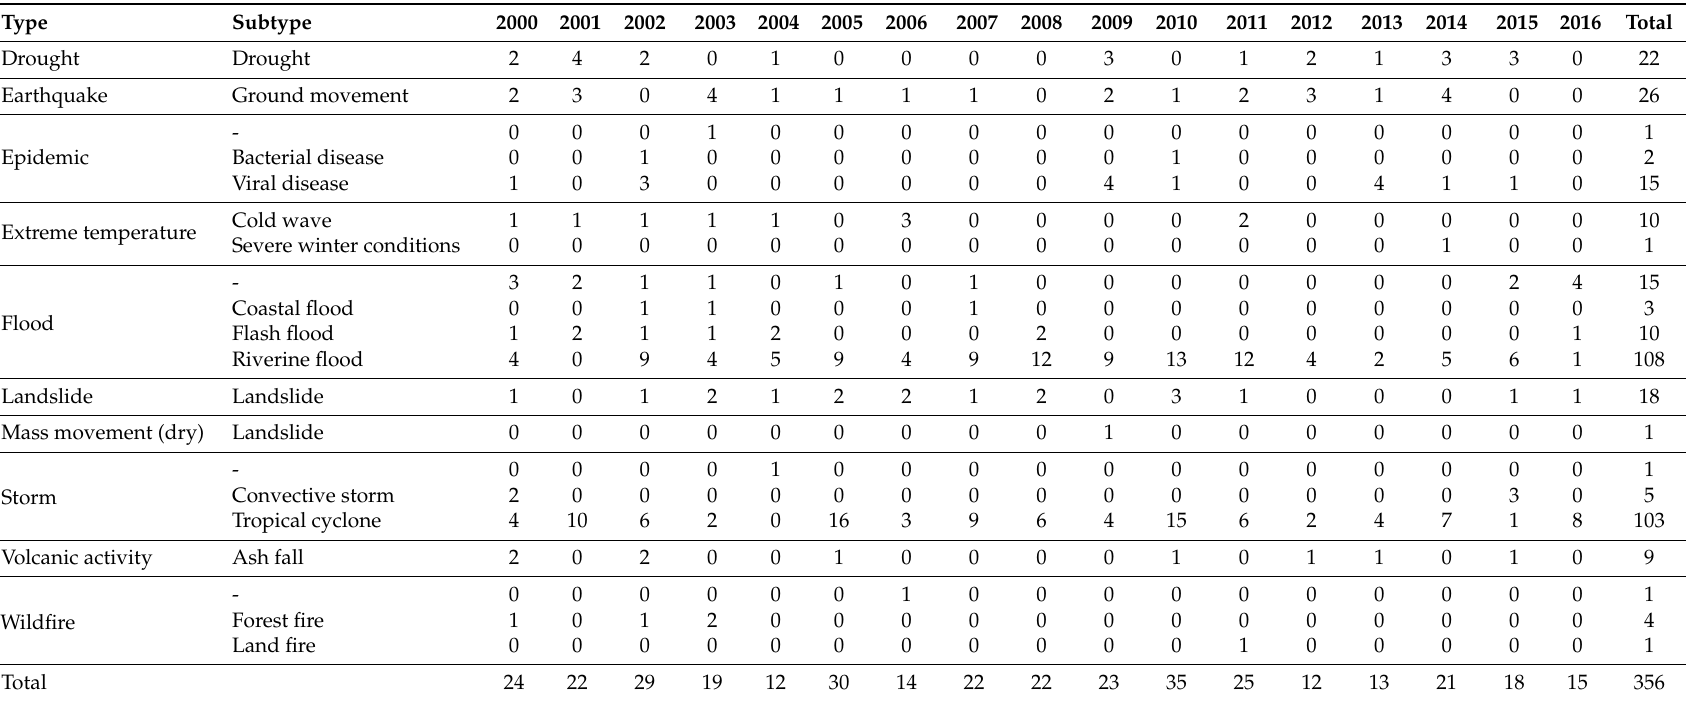
Table A1. Number of natural disasters by type and subtype, Central America,